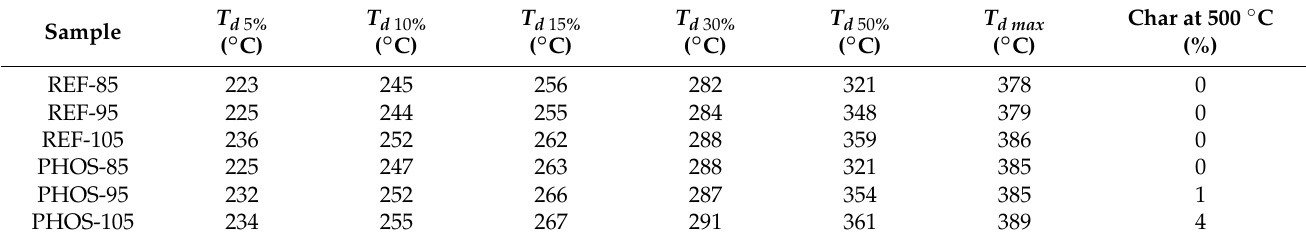
Table 3. Temperatures of degradation and values of char at 500 ◦ C of flexible foams.